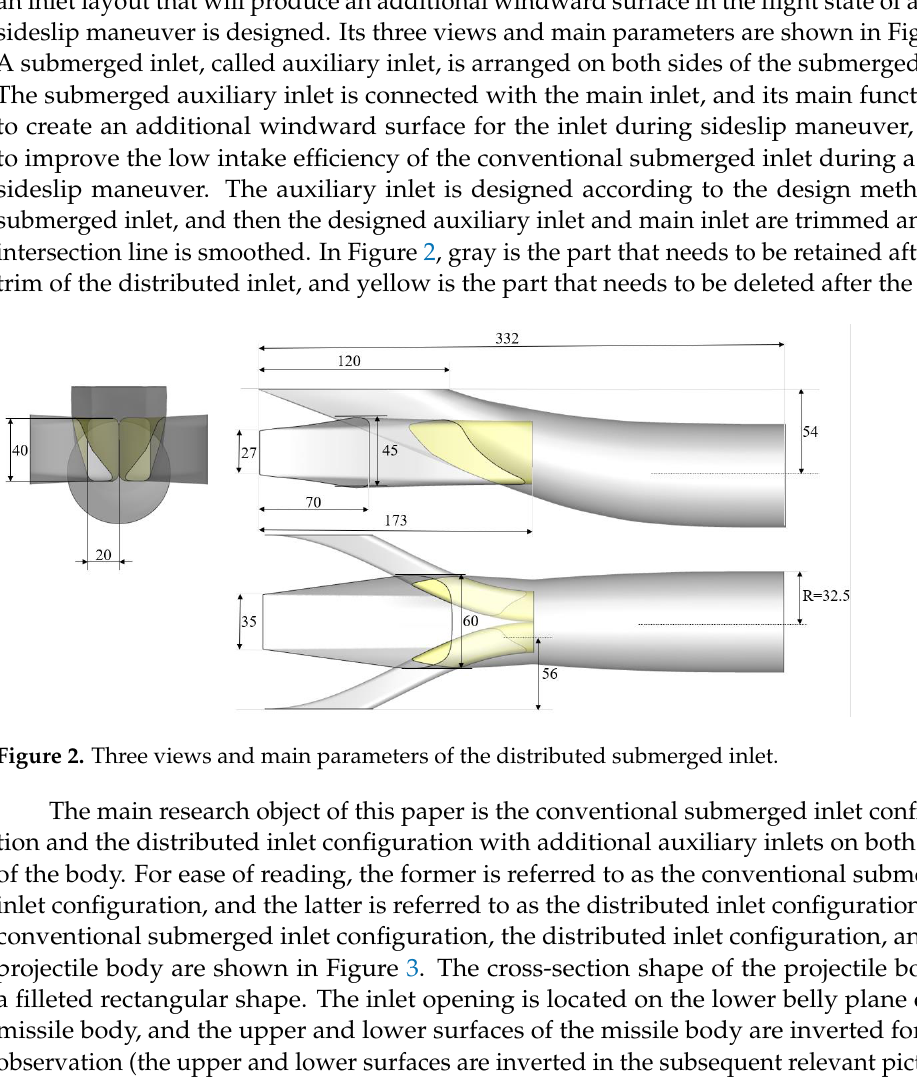
( e ) Figure 4. Surface mesh of projectile body, inlet, and far-field.((a) Surface mesh of missile body in the conventional inlet, (b) Surface mesh of missile body in the distributed inlet, (c ) Surface mesh of the conventional inlet , (d) Surface mesh of the distributed inlet, (e) Surface mesh of far-field) The Spalart – Allmaras turbulence model is mainly used in the numerical simulation in this paper. The S-A turbulence model is a single equation model, which can directly solve the modified turbulent viscosity. It is often used in the flow around the aviation field and is characterized by high accuracy and small amount of calculation. In order to capture the complex flow on the surface of the missile and inlet as well as possible, enhanced wall treatment (EWT) is required, which requires that the near-wall mesh is very dense, and y+ is close to 1. However, considering that too dense near-wall mesh will lead to low mesh quality, the boundary layer mesh shall be properly adjusted without reducing the calcu- lation accuracy. The final number of boundary layers is 10, the first layer of mesh height is 0.01 mm, and the growth rate is 1.2. In order to make the calculation results more accu- rate and reliable, an encryption area is set around the missile body, the maximum size of the encryption area is not more than 30 mm, and an encryption area is also set near the